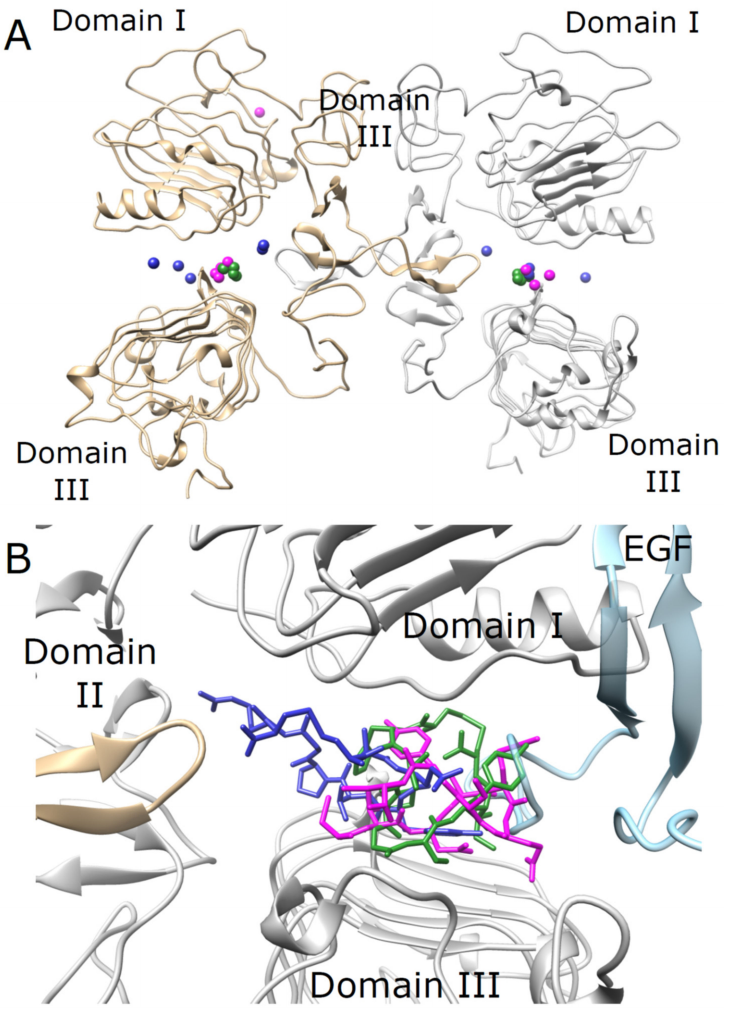
Figure 6. Docked structures of peptides P6, P9, and P11 to the EGFR extracellular region. ( A ) Unbiased rigid body docking of the peptides to EGFR was carried out with the HDOCK